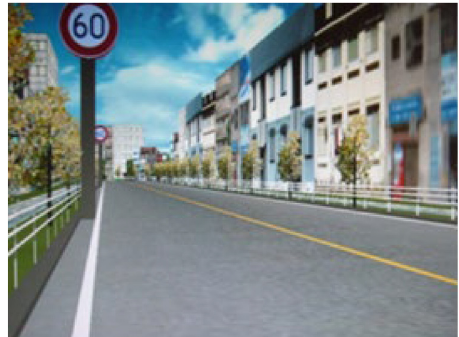
Figure 3 Road conditions of